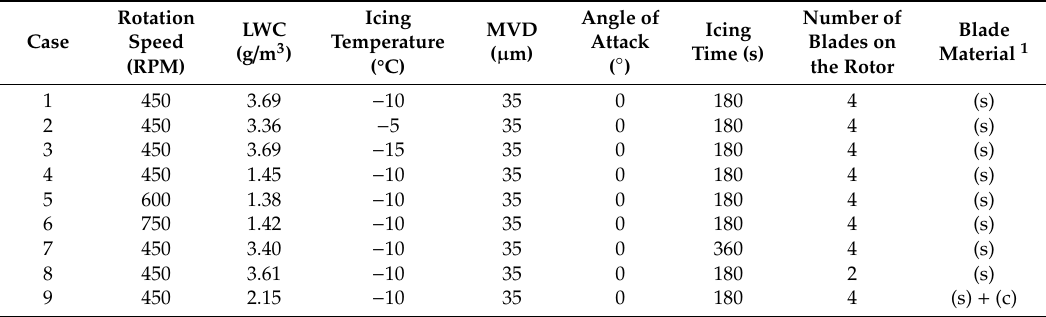
Table 1. Icing experimental